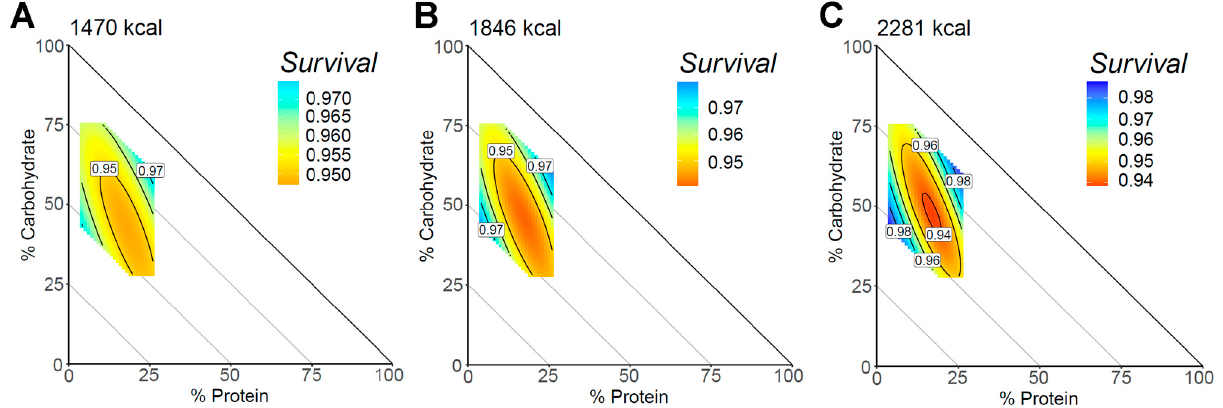
Figure 2. Macronutrient composition with all-cause mortality. The mixture triangle shows the model predictions of the all-cause mortality survival score for the range of macronutrient percentages in this dataset. ( A – C ) The predictions using the 25th, 50th, and 75th percentiles of caloric intake for the study population. The x and y -axes show protein and carbohydrate levels, respectively. Percentage of fat can be inferred as decreasing and moving away from the origin such that each point on the triangle can be summed to equal 100%. Response values are colored such that warm colors show a higher risk of mortality and cooler colors show a lower mortality risk. Response surfaces were adjusted for age, sex, household income, BMI, physical activity, and Healthy Eating Index.